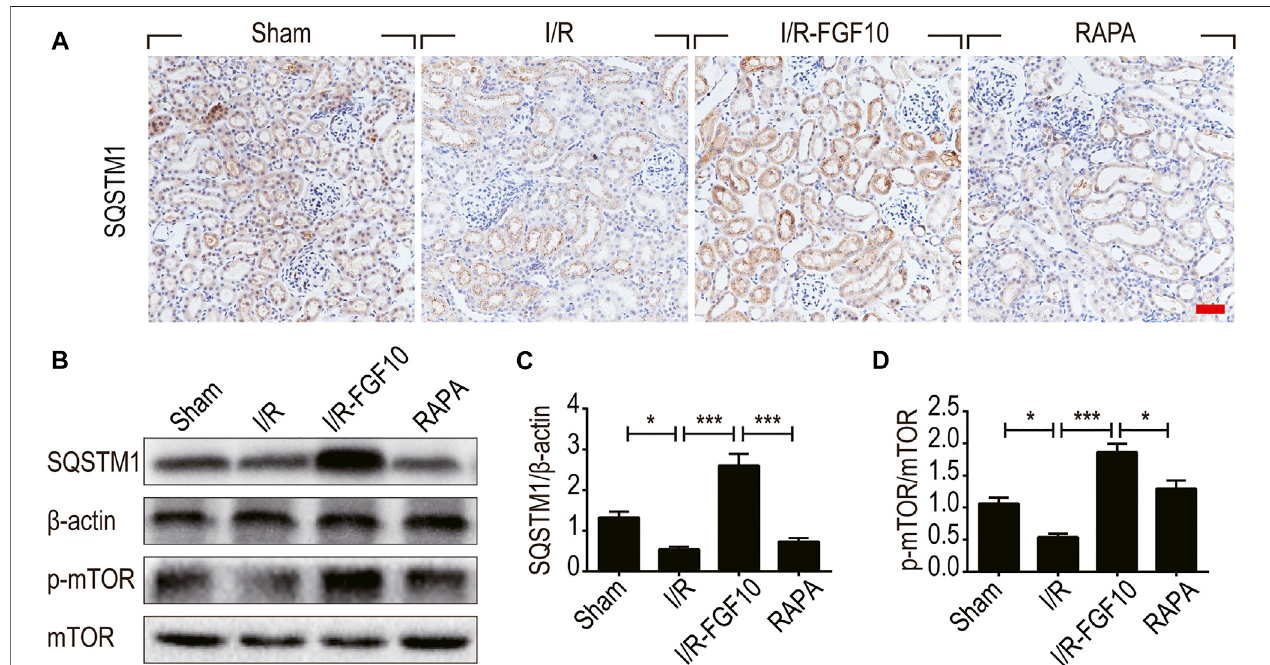
FIGURE6| FGF10increasestheexpressionofSQSTM1andp-mTORinI/Rrats. (A) IHCstainingwasperformedat2 daysafterreperfusionforSQSTM1inkidney tissuesfromindicatedanimalgroups.Scalebars (cid:1) 50 µm. (B) TheexpressionofSQSTM1,p-mTORandmTORweredetectedbywesternblotting(mean ± SEM; n (cid:1) 5). β -actinwasusedascontrol. p p < 0.05, ppp p < 0.001. (C,D) OpticaldensityanalysisforSQSTM1andp-mTOR,whichwerenormalizedto β -actinandmTOR,respectively.